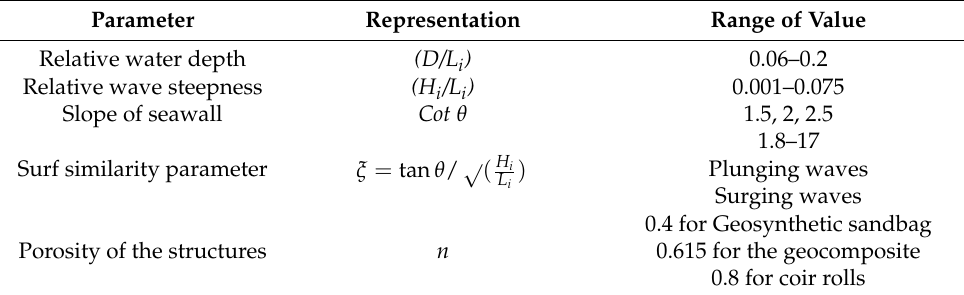
Table 6. Non-dimensional parameters for the